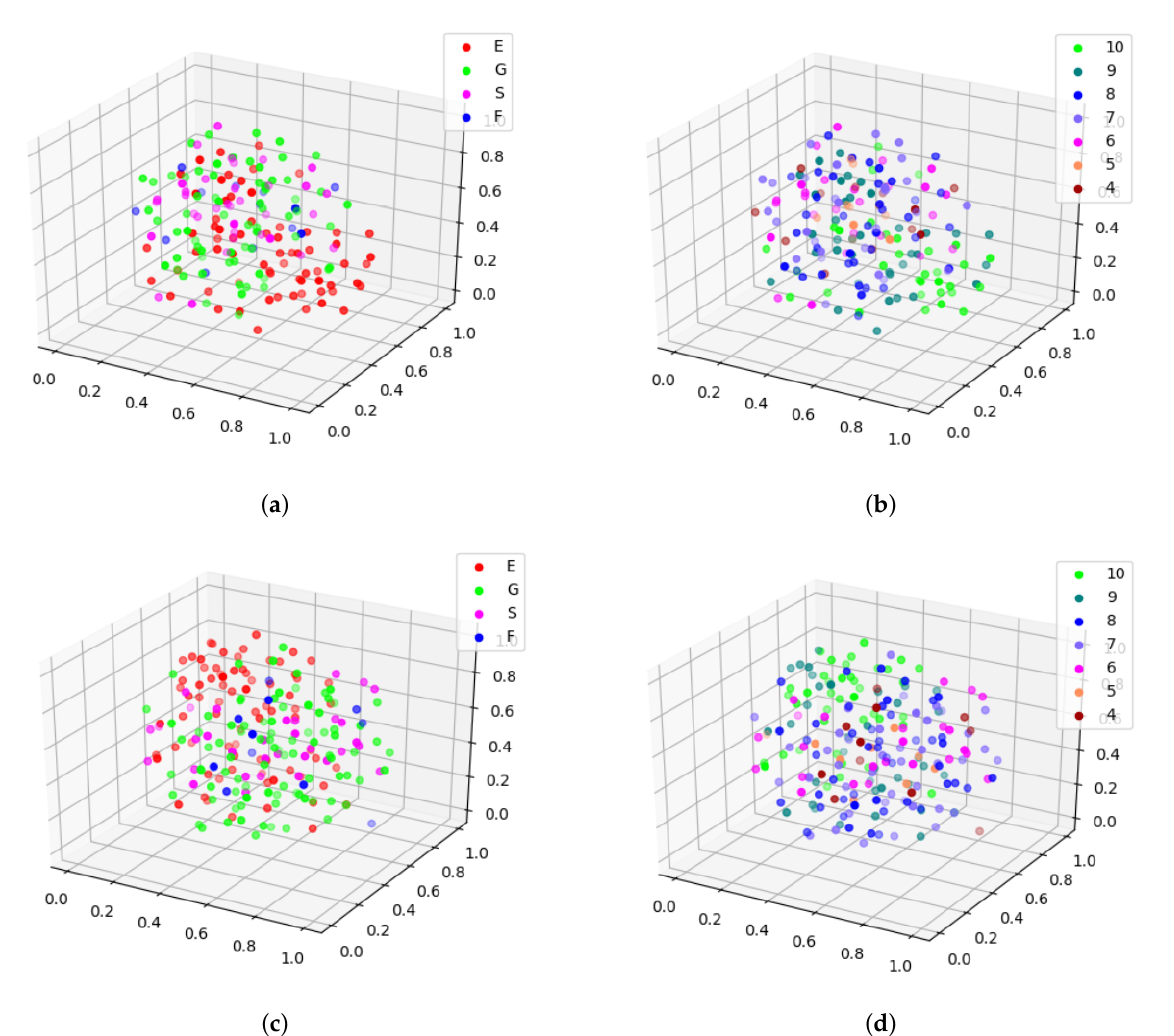
Figure 5. 3D t-SNE visualizations for the first case study: data set D t and the category ( a ) and grade -based classifications ( b ); data set D o and the category ( c ) and grade -based classifications ( d